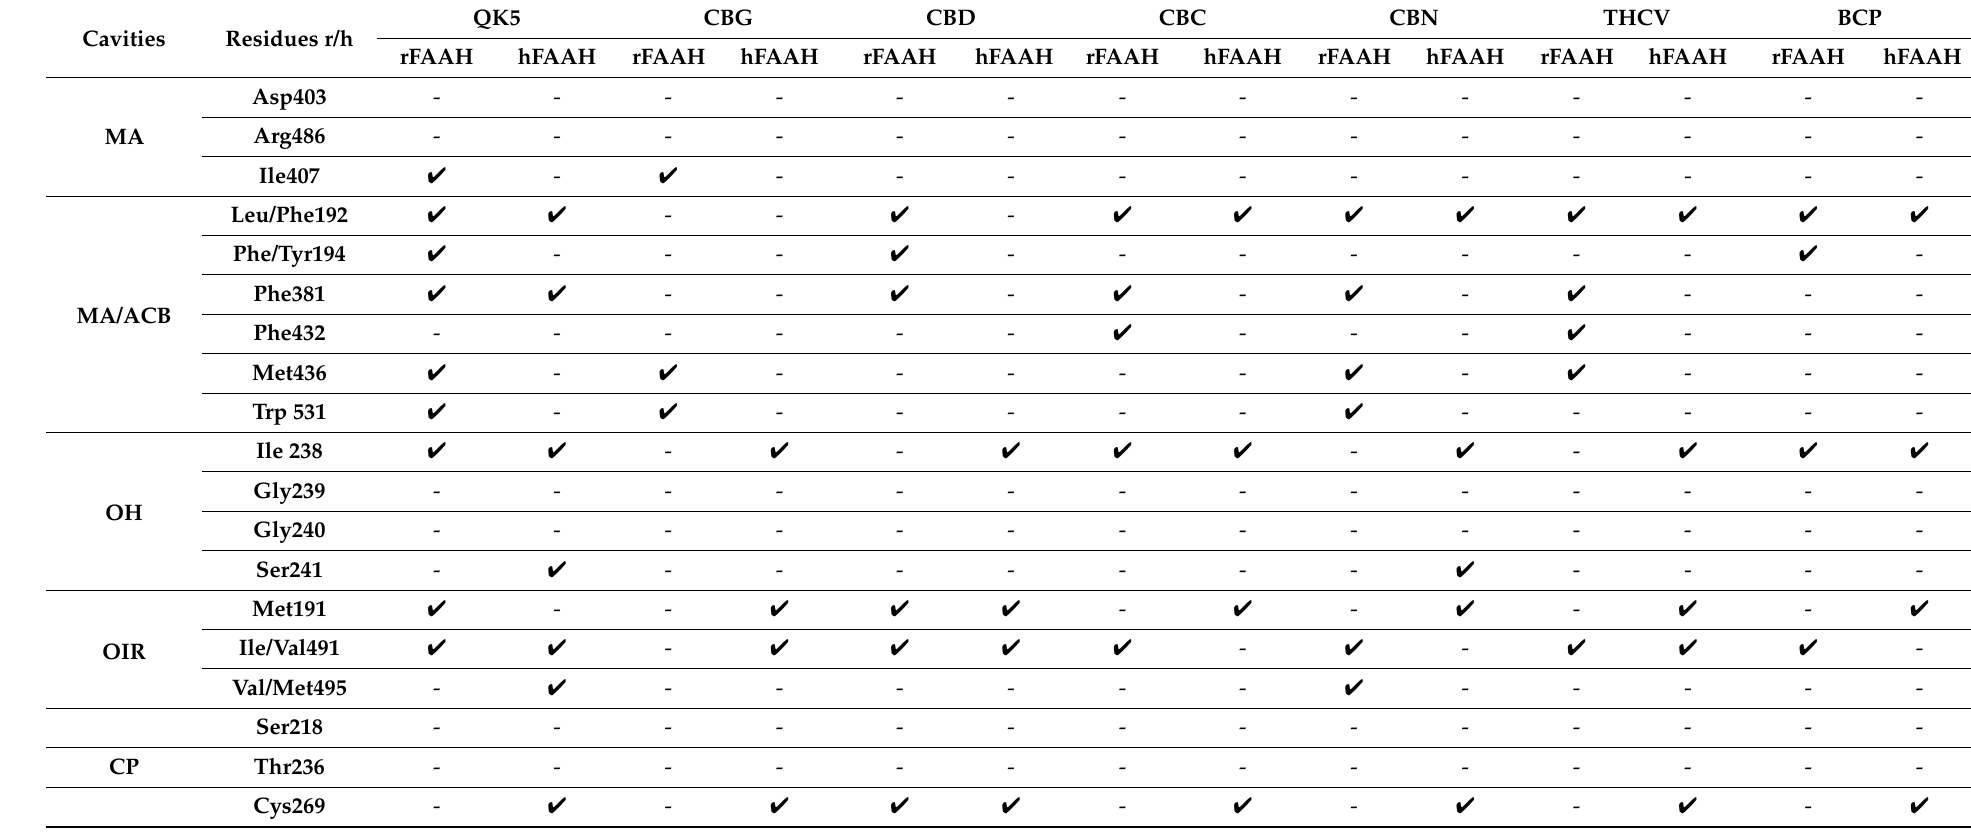
Table 2. Interaction summary of key rFAAH residues in both enzymes with QK5 and cannabis-derived compounds. Cavities